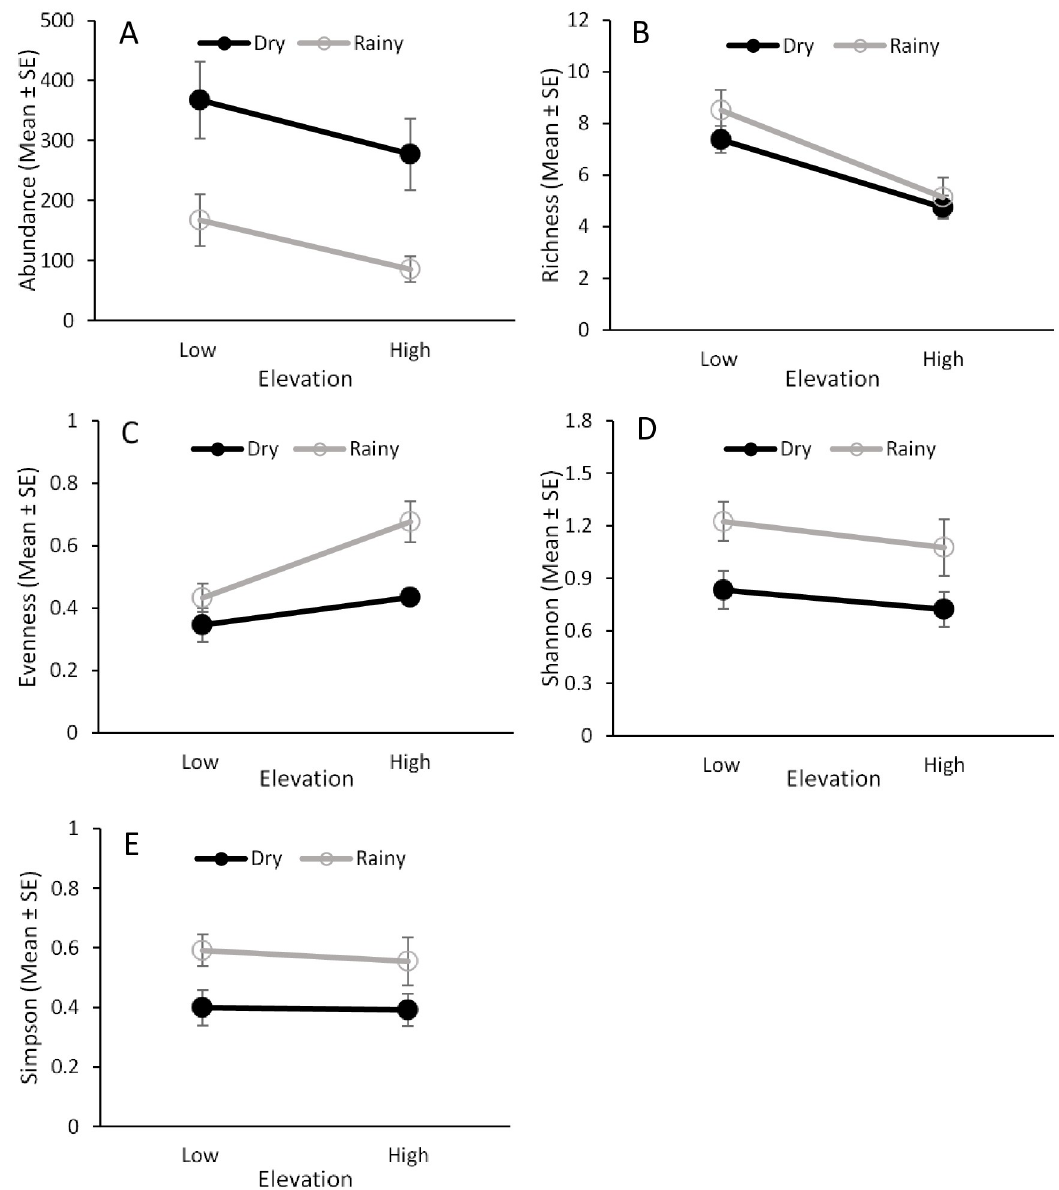
traps placed in guava orchards from